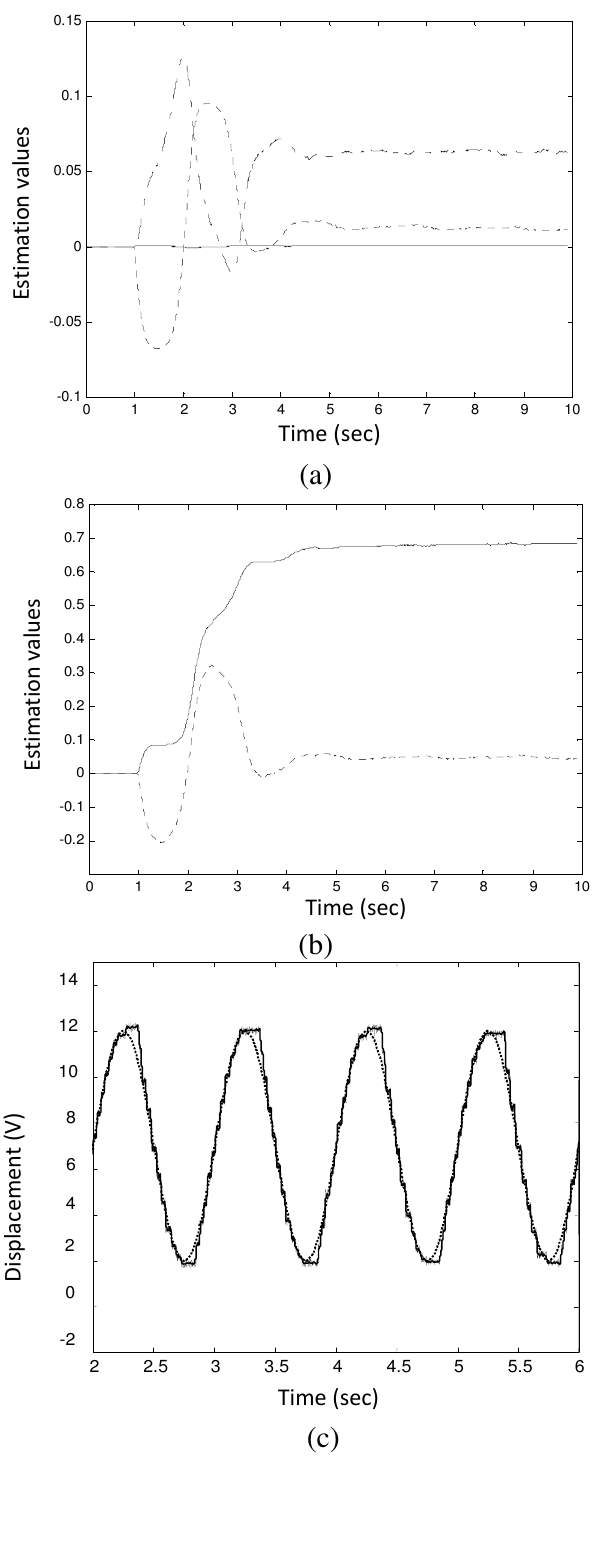
Figure 3. Parameter identification for valve V line; (b) â : solid line, â : dot line; (c) the tracking signal (solid line) and the reference input f 0 (dot line) during